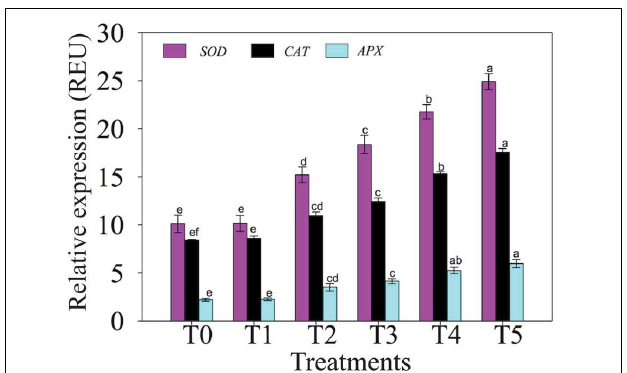
FIGURE 4 | Effects of NO on expression levels of selected SOD , CAT and APX genes in leaves of chickpea plants under salt stress. Data presented are the means ± SEs ( n = 5). Different letters indicate significant difference ( P ≤ 0.05) among the treatments. T0 (control) = 0